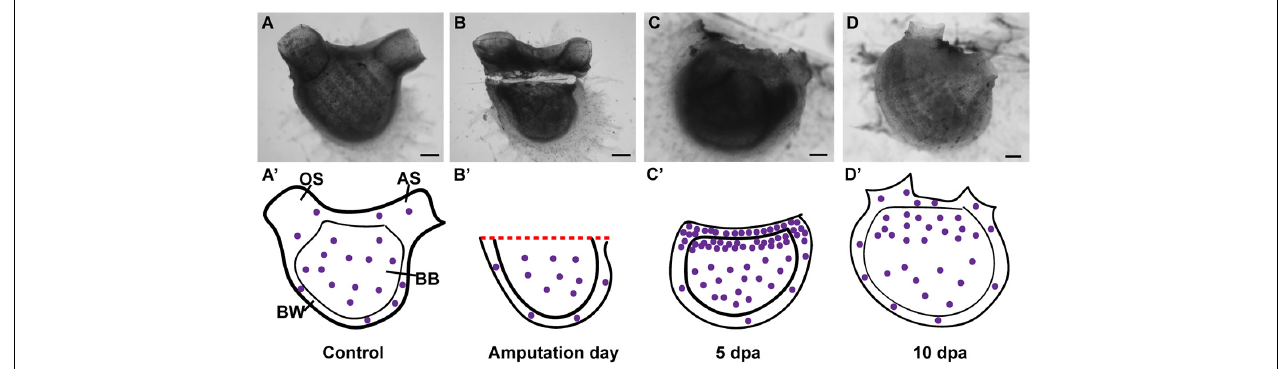
FIGURE 7 | Summary of proliferating cell dynamic in P. mytiligera inferred from EdU experiments. (A,A (cid:48) ) Control. (A) In vivo image, (A (cid:48) ) illustration. During homeostasis, proliferating cells (purple spheres) are evenly dispersal along the branchial basket (BB) and body wall (BW) [Oral siphon (OS), atrial siphon (AS)]. (B,B (cid:48) ) Amputation day. (B) In vivo image, (B (cid:48) ) illustration. The level of proliferating cells remains similar to that of the control. (C,C (cid:48) ) 5 days following anterior amputation. (C) In vivo image, (C (cid:48) ) illustration. Proliferating cells specifically accumulate at the amputation site in the branchial basket and body wall in proximity to the regenerating area. (D,D (cid:48) ) 10 days following amputation. (D) In vivo image, (D (cid:48) ) illustration. As the amputated structures regenerated, the level of proliferating cell decreased in relation to 5 dpa, although remaining higher than those of the control. Scale bar in (A,B) : 1 mm, and in: (C,D) : 500 µ